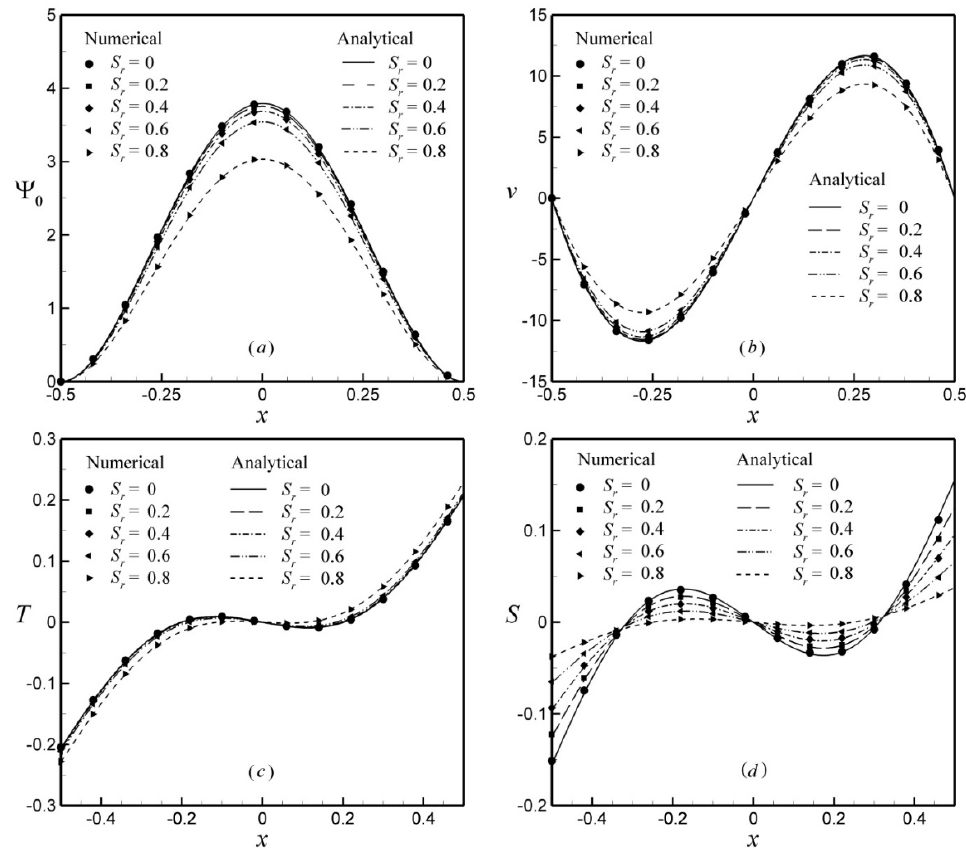
Figure 6. Stream function ( a ), velocity ( b ), temperature ( c ), and concentration ( d ) profiles in x -direction at mid-height of the enclosure for A = 10, Da e = 1, Le = 10, R T = 10 4 , ξ = 0, ε = 1, D u = 0 and various values of S r .